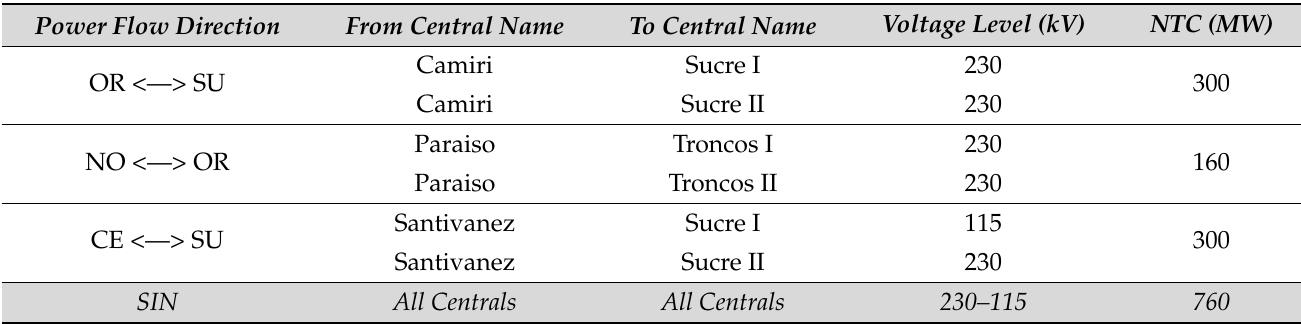
Table 5. Transmission projects planned for the period 2020–2025